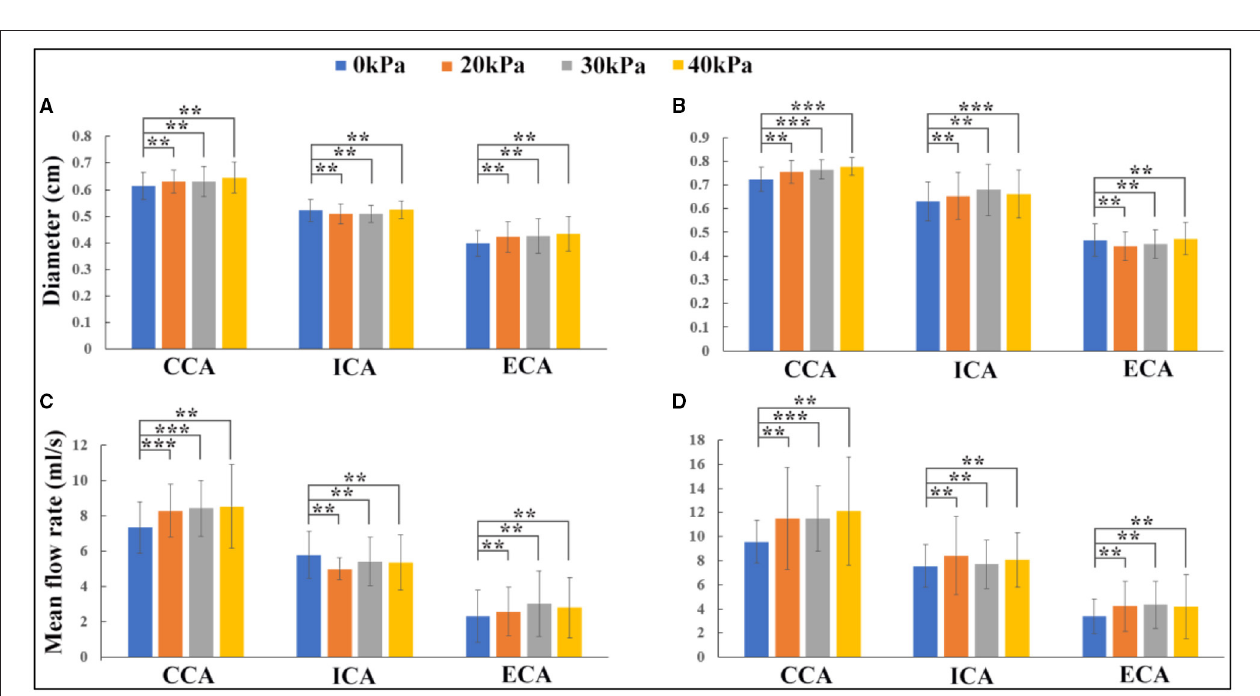
FIGURE 2 | Geometry and boundaries of a carotid artery model. Note that the extension of the internal carotid artery (ICA) outlet is not included.